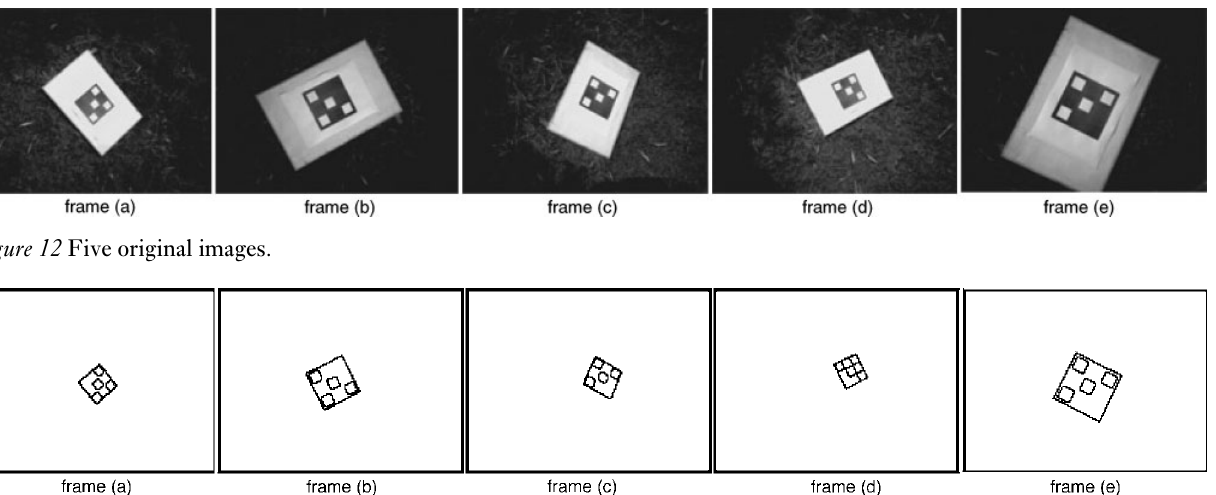
Figure 13 Five images after edge